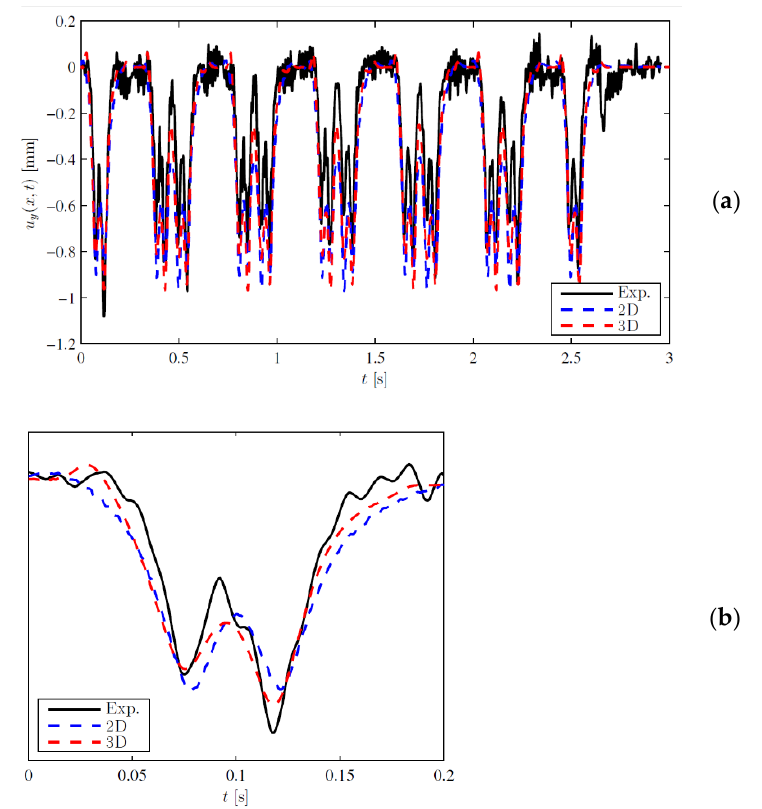
Figure 5. Vertical displacement of the rail: comparison between experimental measurements, fitted numerical results (2D) from [46] and numerical results (3D) obtained here; ( a ) full vehicle; ( b ) first bogie.